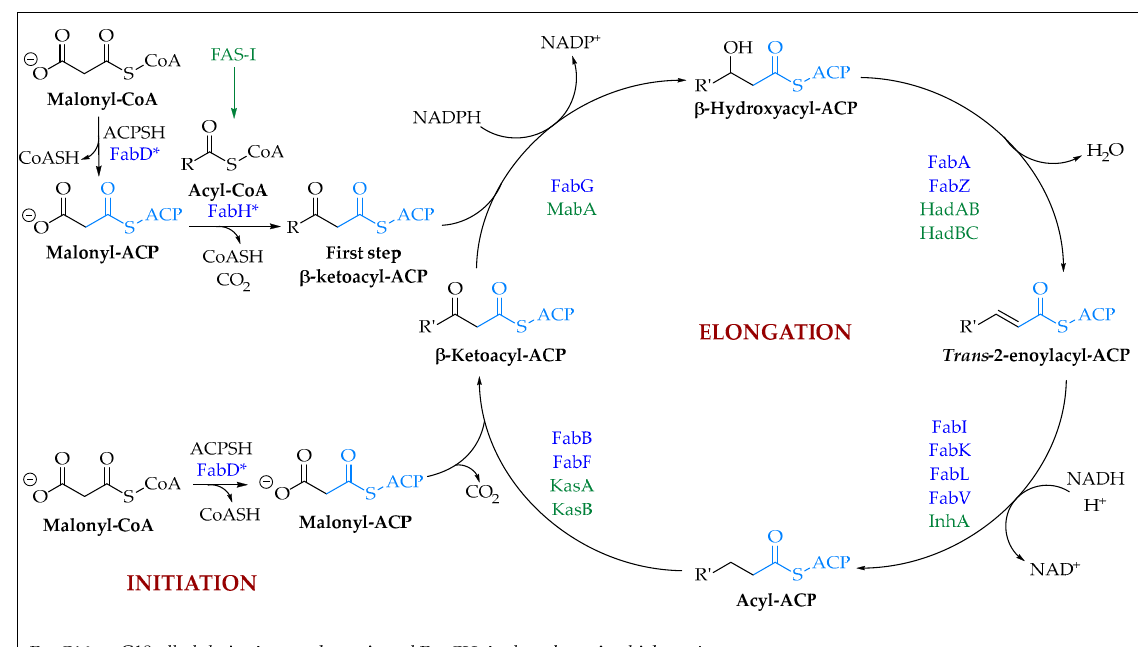
Scheme 1. Schematic of type II fatty acid synthase system. Enzymes in green exist in my-